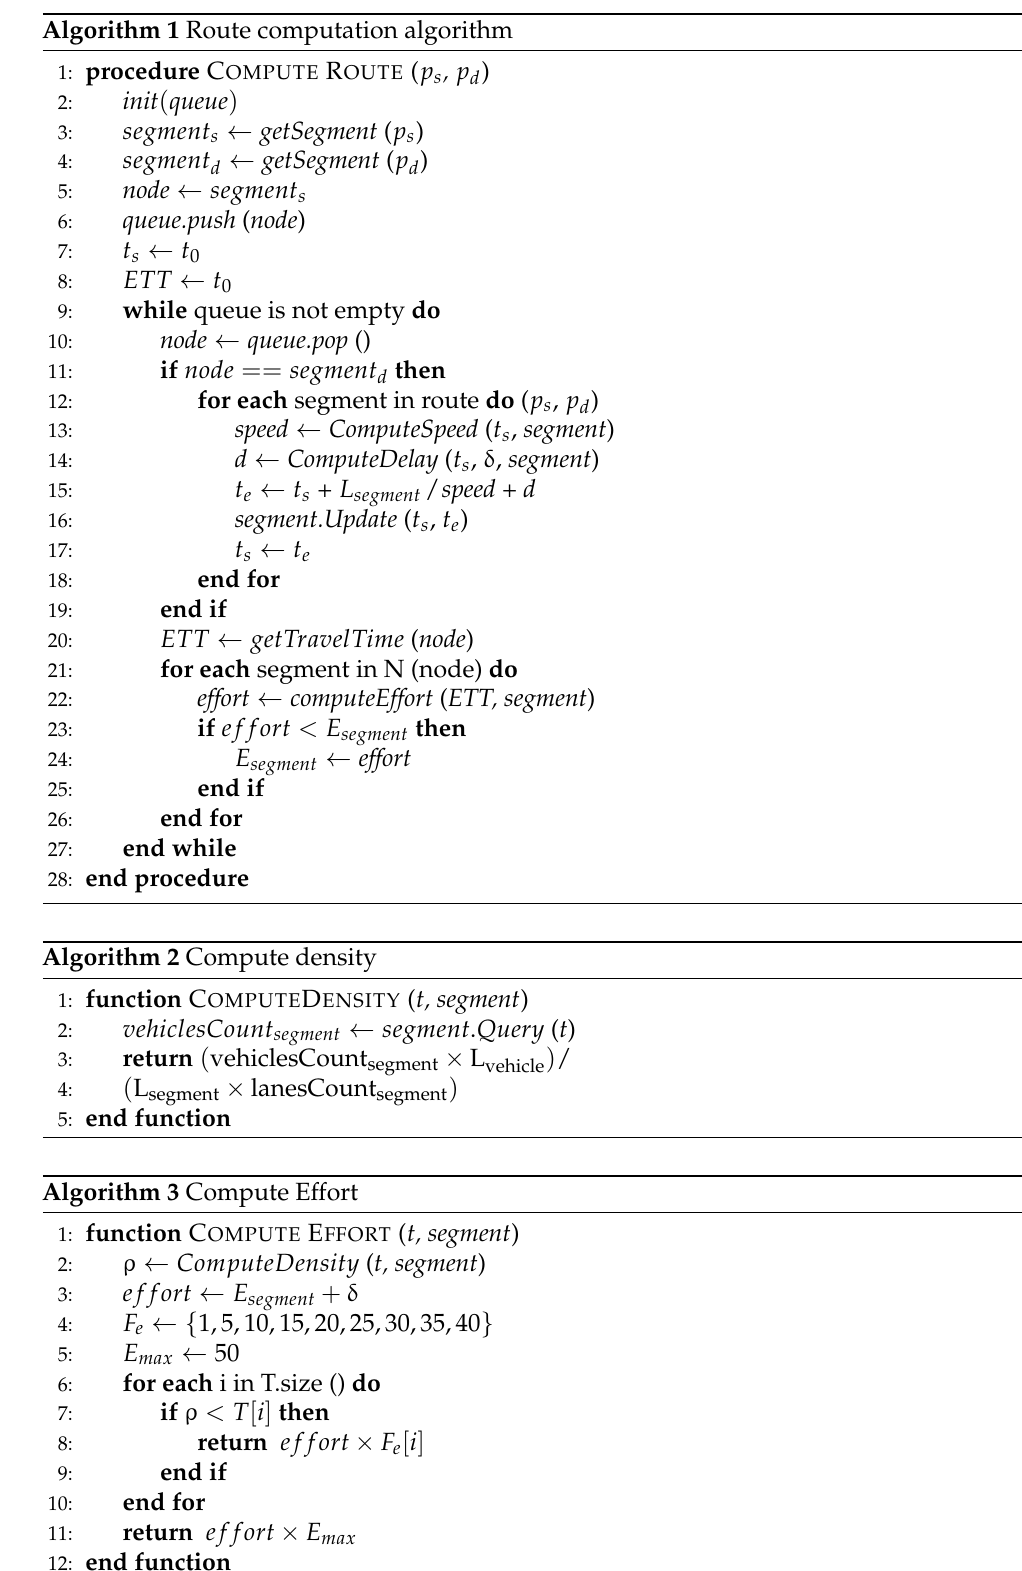
Algorithm 1 Route computation algorithm